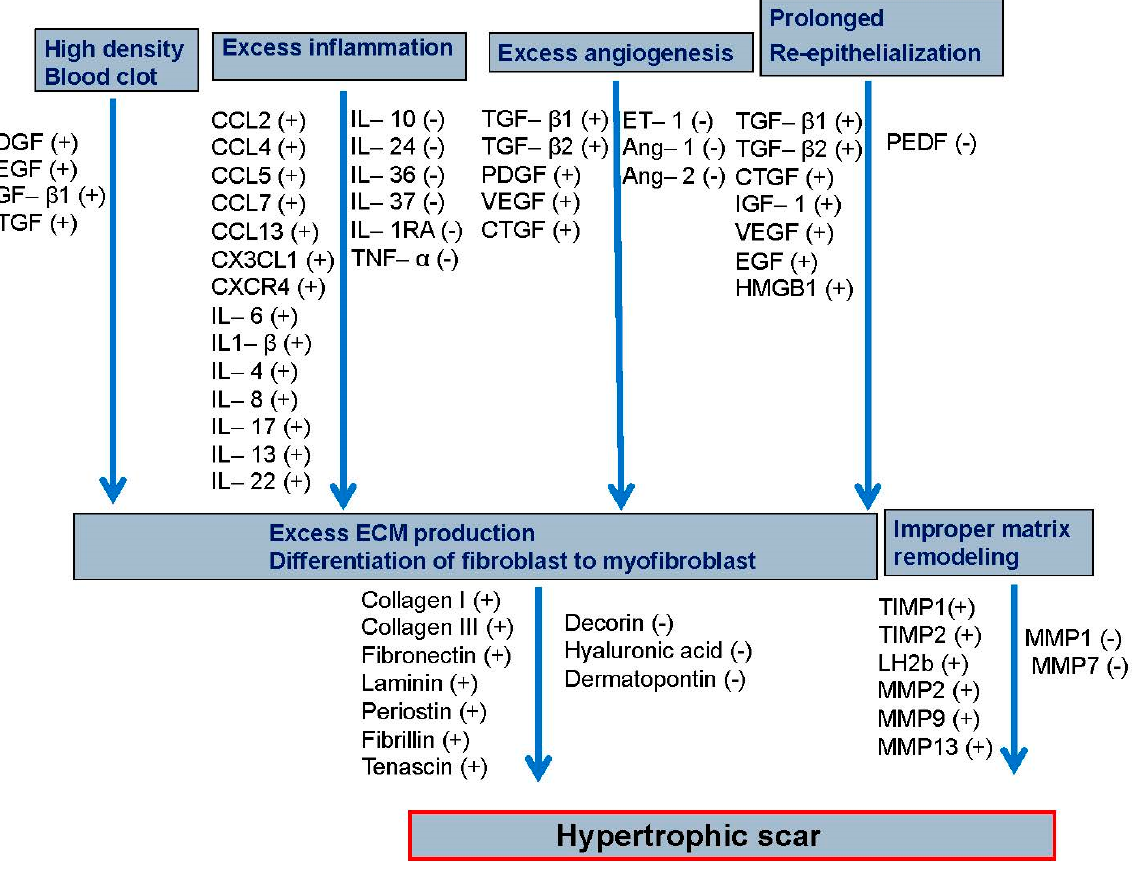
Figure 3. The events and molecules associated with hypertrophic scar (HTS) formation. The pro-fibrotic molecules generated from the high-density blood clot induce excessive inflammation, angiogenesis, and prolonged re-epithelization. The resultant excessive production of extracellular matrix and fibroblast differentiation and improper matrix remodeling then causes formation of hypertrophic scarring. Molecules with increased expression are denoted with (+), whereas those with decreased expression are denoted with ( − ). The players included in this fi gure are discussed in the text.